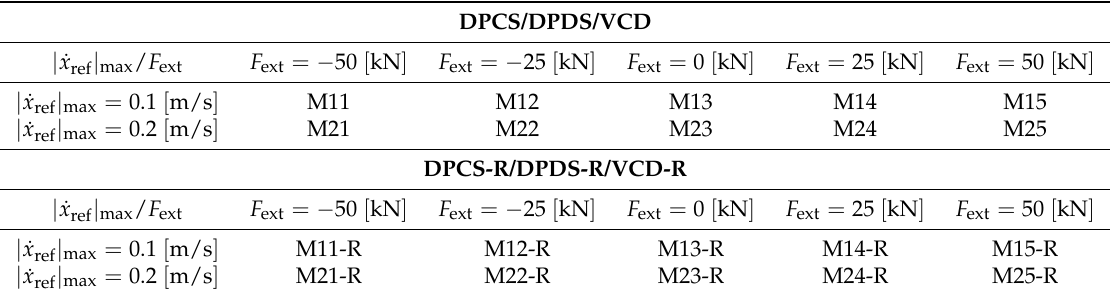
Table 2. Different modes considered in evaluation of the proposed drive class.